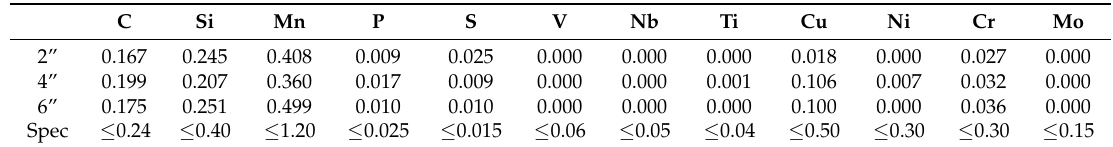
Table 1. Chemical composition of collected pipe materials and that for PSL 2 seamless X42 pipe in API Spec 5L-2013.